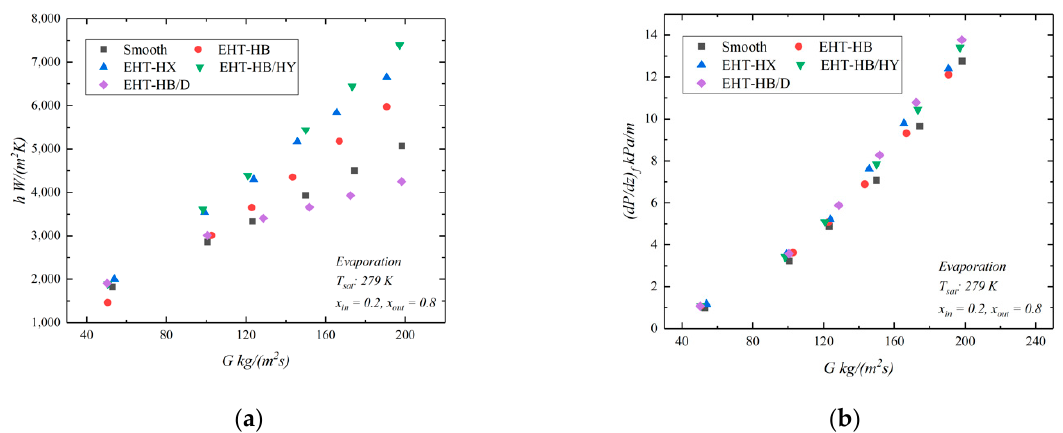
Figure 8. Tubeside flow boiling performance comparison (using R410A) of heat transfer tubes as a function of mass flux (G) for: ( a ) condensation HTC and ( b ) pressure drop.